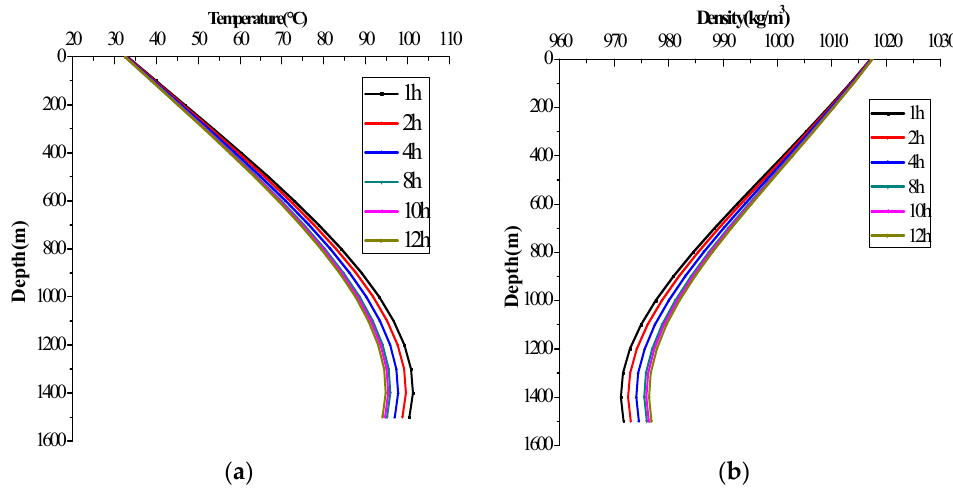
Figure 5. Temperature ( a ) and ECD ( b ) in the annulus with the circulation time. The relations of the drilling fluid temperature in the annulus and the flow rate are shown in Figure 6a. The flow rate is connected with the strength of convection, which has a large influence on the distribution of temperature in the wellbore because of the high temperature. The larger velocity of the drilling fluid flows into the well, while the lower temperature distributes into the annulus. Figure 6b expresses the ECD in the annulus with depth under a different flow rate. Big differences exist in the different flow rate; there is a positive correlation between the flow rate and the ECD, as the flow rate effect not only changes the density, but also the friction pressure loss.